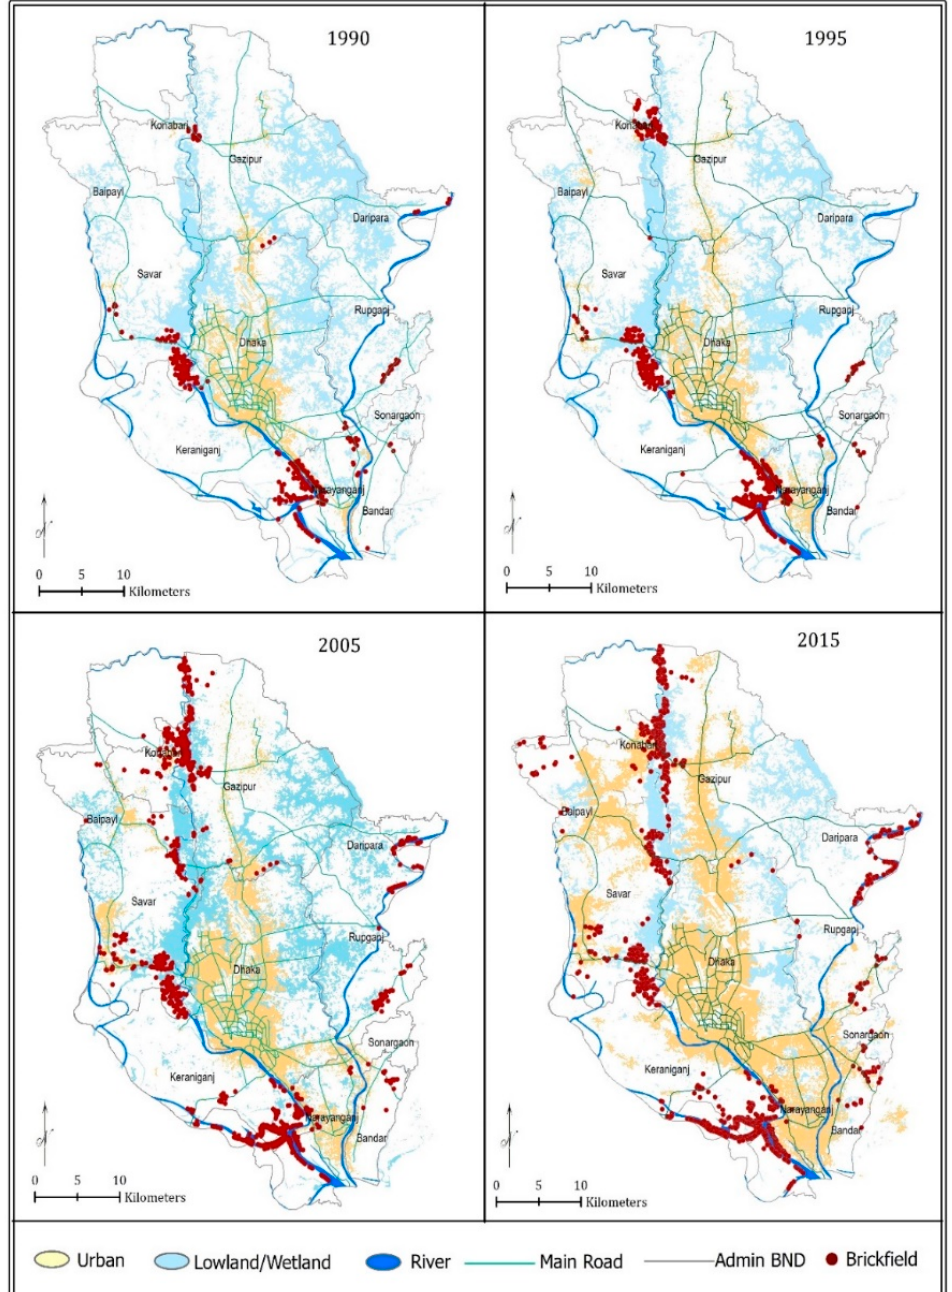
Figure 4. Brickfield spatial expansion in Greater Dhaka from 1990 to 2015.